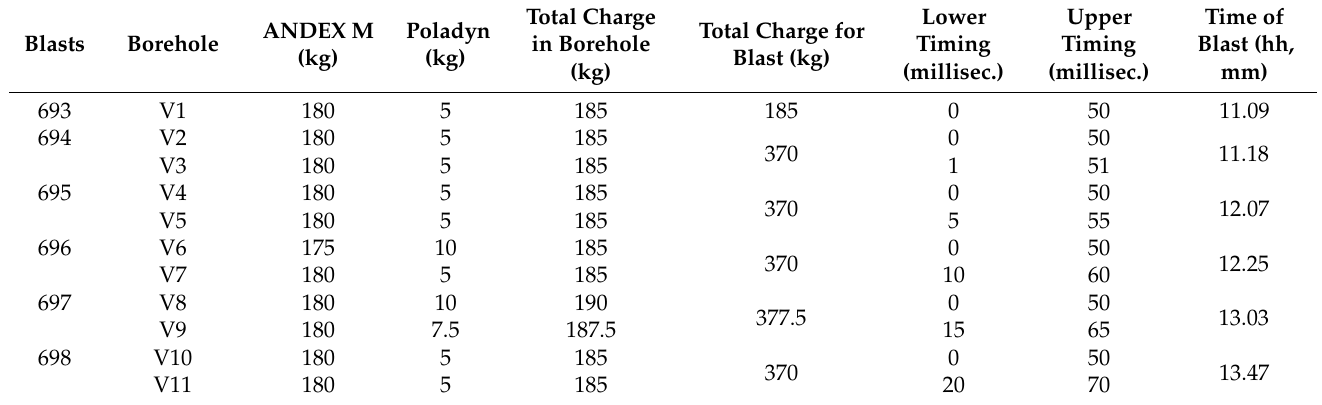
Table 2. Parameters of the blasts in quarry